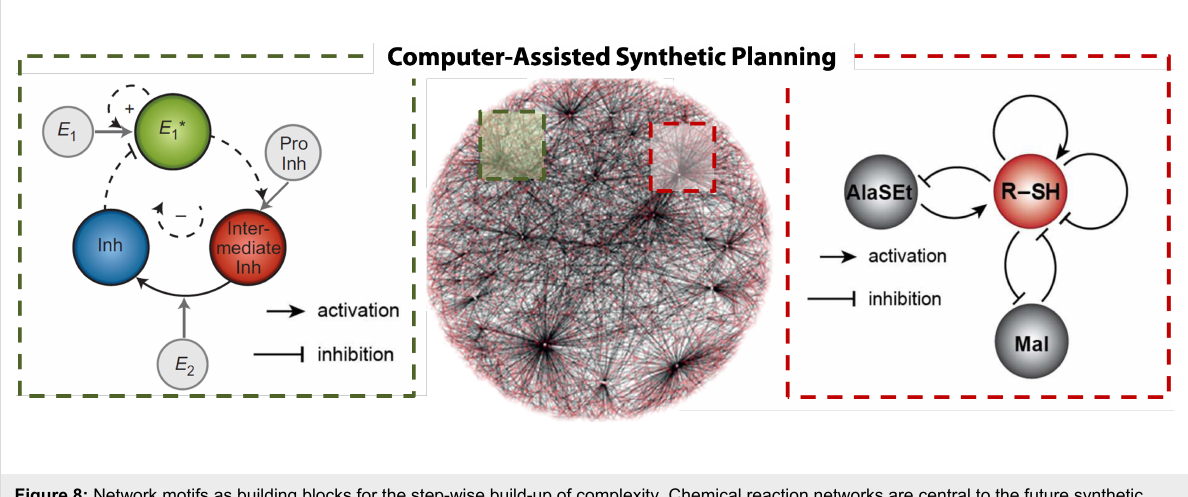
Figure 8: Network motifs as building blocks for the step-wise build-up of complexity. Chemical reaction networks are central to the future synthetic moves in systems chemistry. Adapted with permission from [94] copyright 2015 Nature Publishing Group, [101] copyright 2016 Nature Publishing Group, and [102] copyright 2016 Wiley-VCH Verlag GmbH &